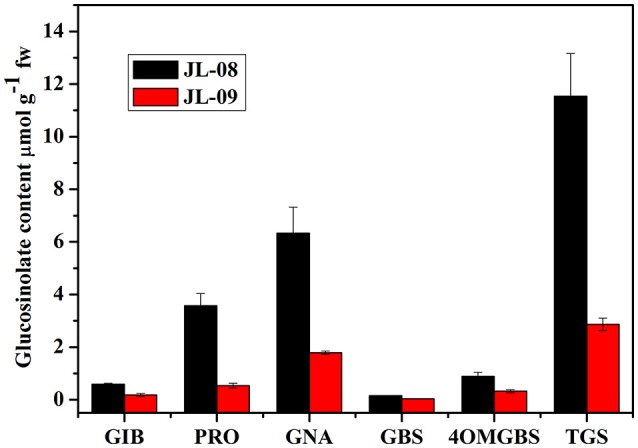
Profiles and contents of GS in JL-08 and JL-09 sprouts. The X axis represented the profiles of glucosinolate in JL-08 and JL-09 sprouts. GIB, Glucoiberin; PRO, Progoitrin; GNA, Gluconapin; GBS, Glucobrassicin; 4OMGBS, 4-Methoxy glucobrassicin; TGS, Total glucosinolate. The Y axis is the content of individual and total glucosinolate in JL-08 and JL-09 sprouts. Black column, JL-08; Red column, JL-09. The error bar represents the ± SE.